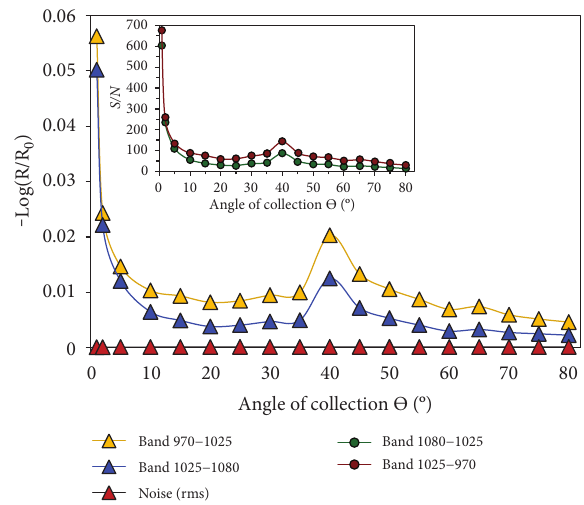
Figure 4: PETN (200 μ g/cm 2 ) vibrational band intensities and S/N (inset) at di ff erent angles (o ff set) of collection ( ϴ